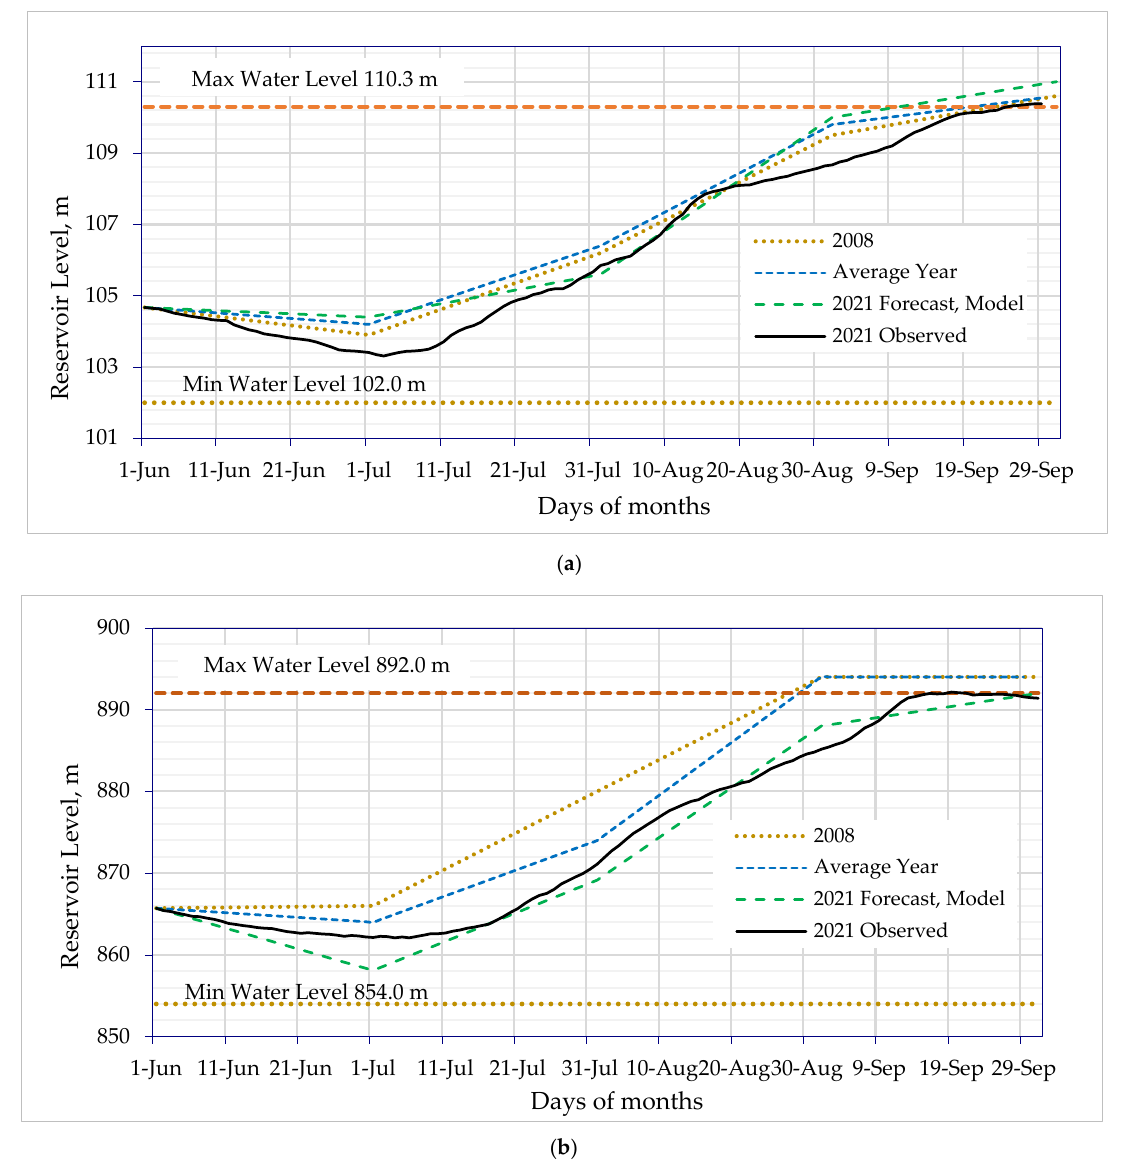
Figure 11. Seasonal water level forecast for Koka ( a ) and Gibe-3 ( b ) reservoirs. The reservoir water level was 104.67 m on June 1 with storage of 294.34 Mm 3 at Koka and 865.71 m with 10,056.5 Mm 3 of storage at Gibe-3 reservoir. The flow forecast values, water levels, and storage at the end of each month for the target years were estimated and are presented in Table 5. In the table, for instance, the model estimated and observed Koka reservoir water levels at the end of September reached 110.60 and 110.36 m,